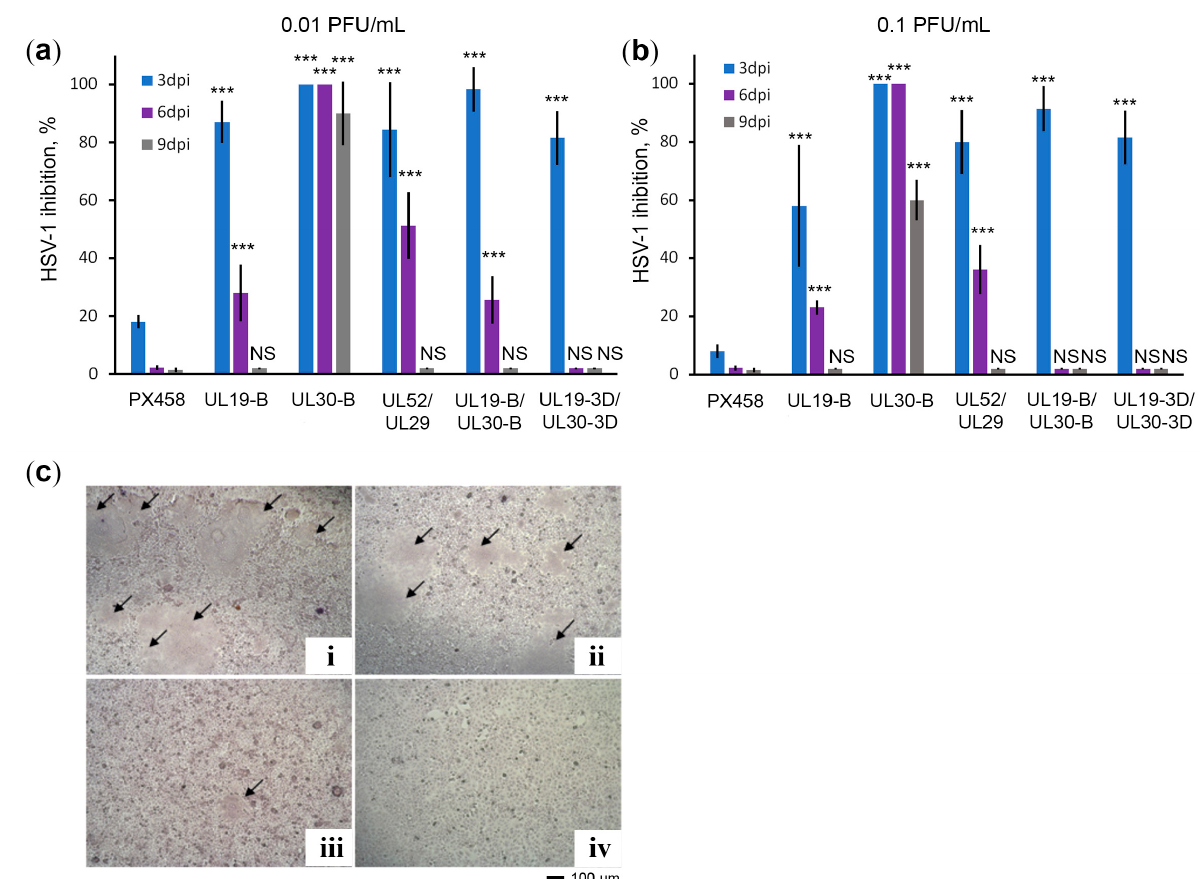
Figure 2. The CRISPR/Cas9 system with a single UL30 spacer completely inhibited HSV-1 infection for at least 6 days. ( a ) Rate of HSV-1 inhibition by CRISPR/Cas9 plasmids in Vero cultures infected with HSV-1 at a concentration of 0.01 PFU/mL. Data are mean ± SD ( n = 3). Statistical significance: NS–nonsignificant; *** p < 0.001, according to Student’s t test. ( b ) Rate of inhibition of HSV-1 by CRISPR/Cas9 plasmids in Vero cultures infected with HSV-1 at a concentration of 0.1 PFU/mL. Data are mean ± SD ( n = 3). Statistical significance: NS–nonsignificant; *** p < 0.001, according to Student’s t test. ( c ) Typical images of Vero cell cultures at 2 dpi infected with supernatants from HSV-1 infected cells at day 6 that were not previously transfected ( i ), transfected with empty vector ( ii ), transfected with plasmid CRISPR/Cas9 targeting UL30 ( iii ), or uninfected cells ( iv ). Arrows indicate areas of infected cells (plaques).